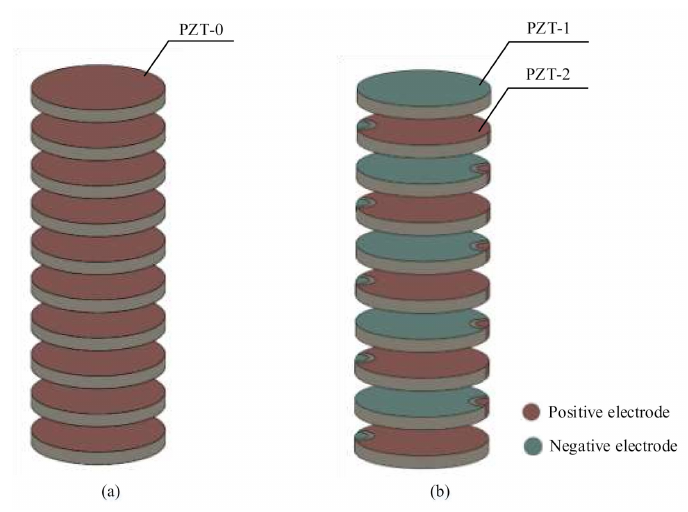
Figure 2. The structures of the PZT stack: ( a ) stack in series; and ( b ) stack in parallel.